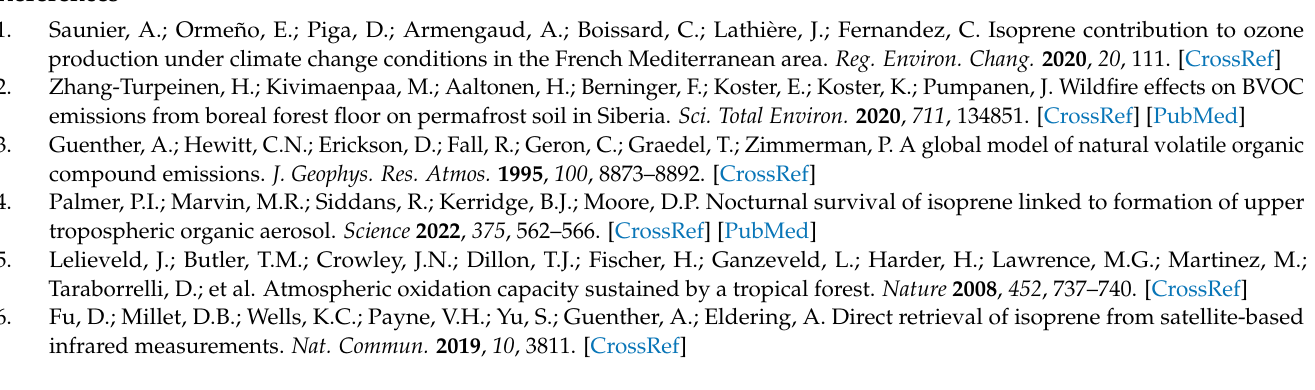
Figure S3: Under short and long drought durations, the value for chlorophyll